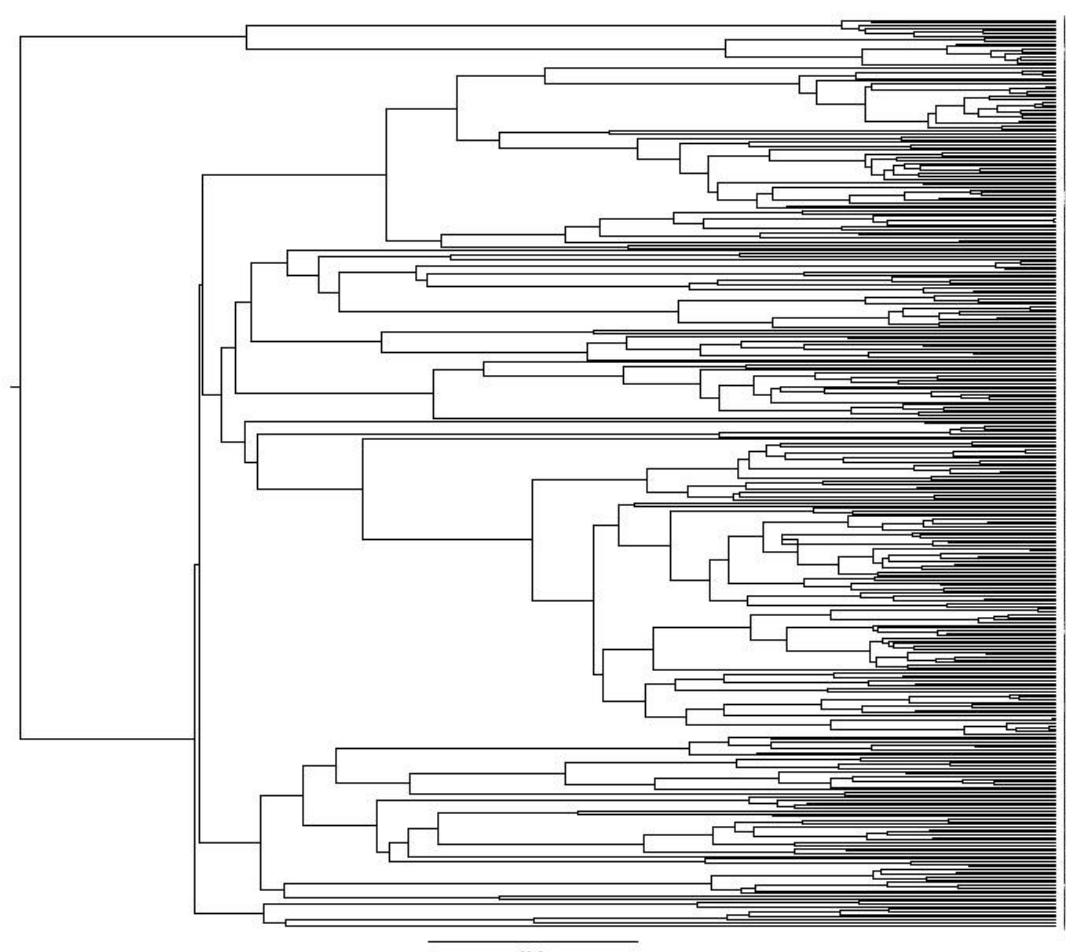
Figure 2 : Phylogenetic tree of total 342 bird species reported in IBAs of Sri